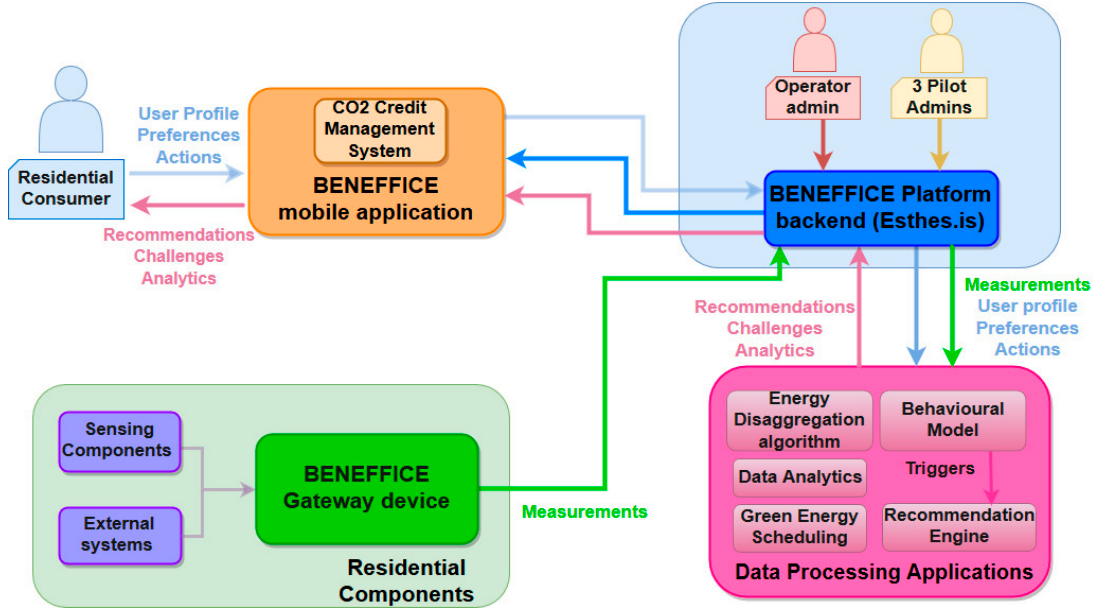
Figure 1. BENEFFICE system architecture and